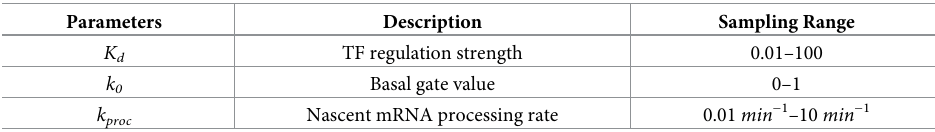
compare all the GRSs, we simulated resulting gene expression with k = 1 RPKM/min (where syn RPKM means reads per kilobase per million of mapped reads), and normalized the gene expression such that its maximal value corresponds to 100 across all the perturbation condi- tions. This is equivalent to adjusting k In Table 1, you can find a summary of the different syn .